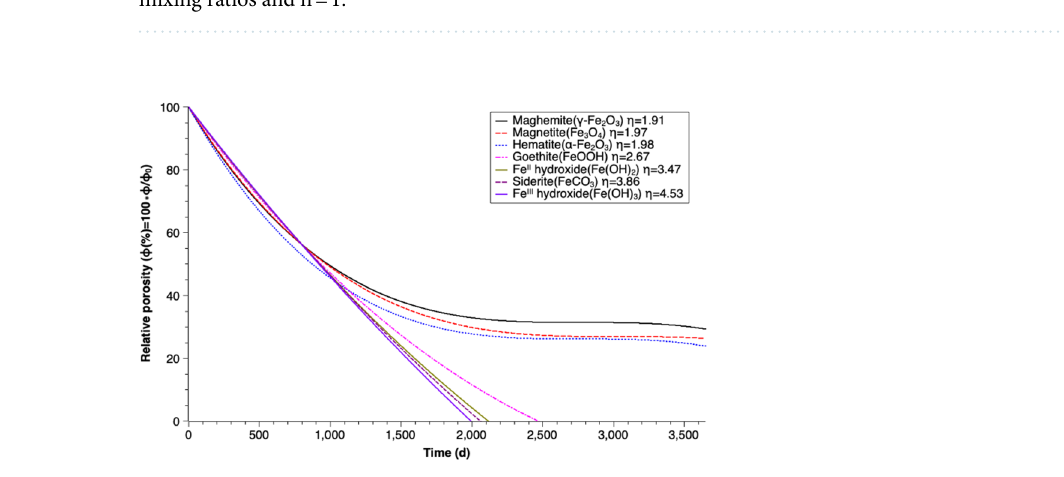
Figure 5. Percentage decrease of relative porosity through the formation of goethite over time for different iron mixing ratios and n = 1.